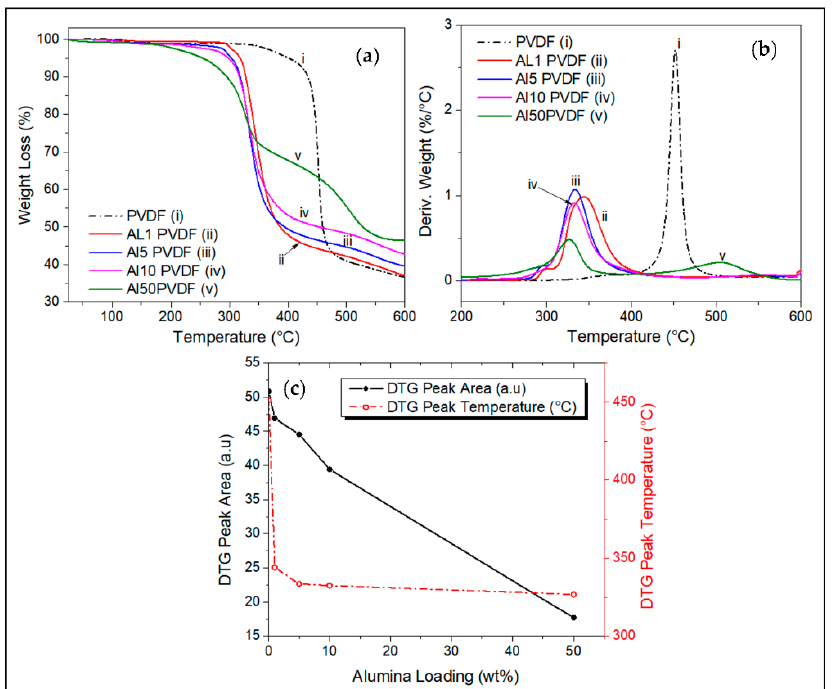
Figure 5. ( a ) TGA thermogram comparisons of effect of Alumina loading on PVDF, with their respective ( b ) derivative weight curves, carried out from room temperature to 600 ◦ C under N 2 atmosphere. ( c ) effect of alumina loading on the DTG peak area and peak temperature.